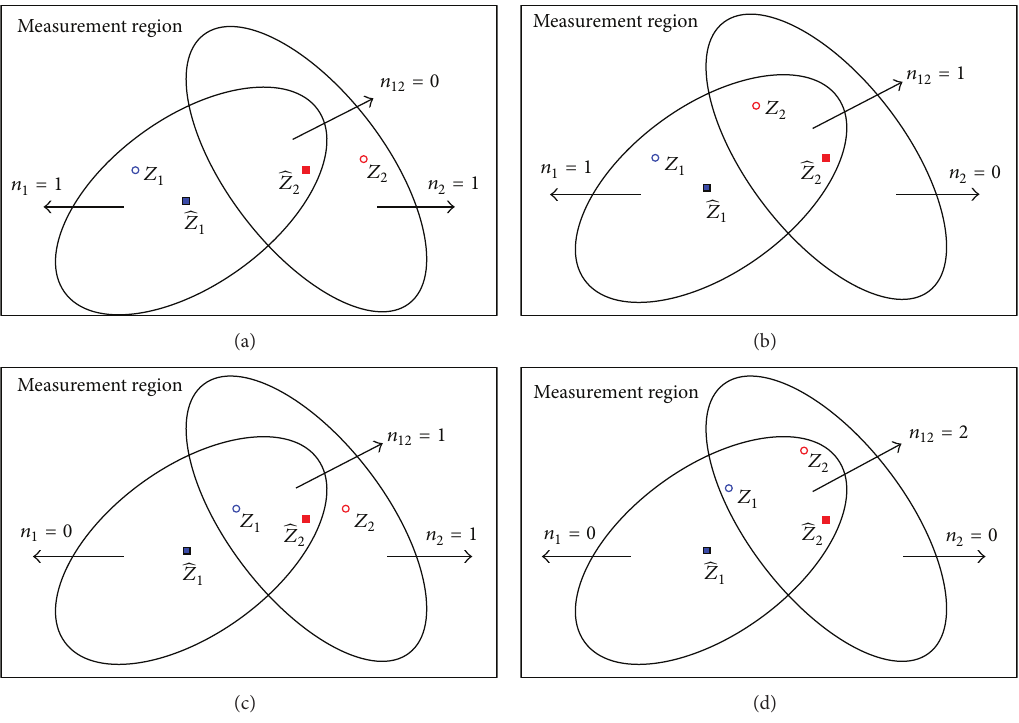
Figure 4: All possible hypotheses for measurements that fall inside two validation regions on condition that 𝑃 𝑑 = 1 .